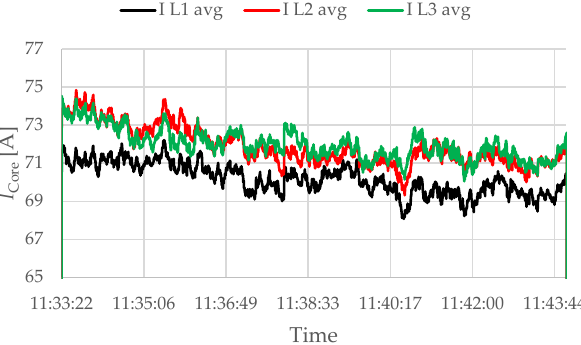
Figure 11. Cores currents measured in Substation 2. Sheaths unearthed and uncrossed (Sh2). Operation only with the analyzed line.